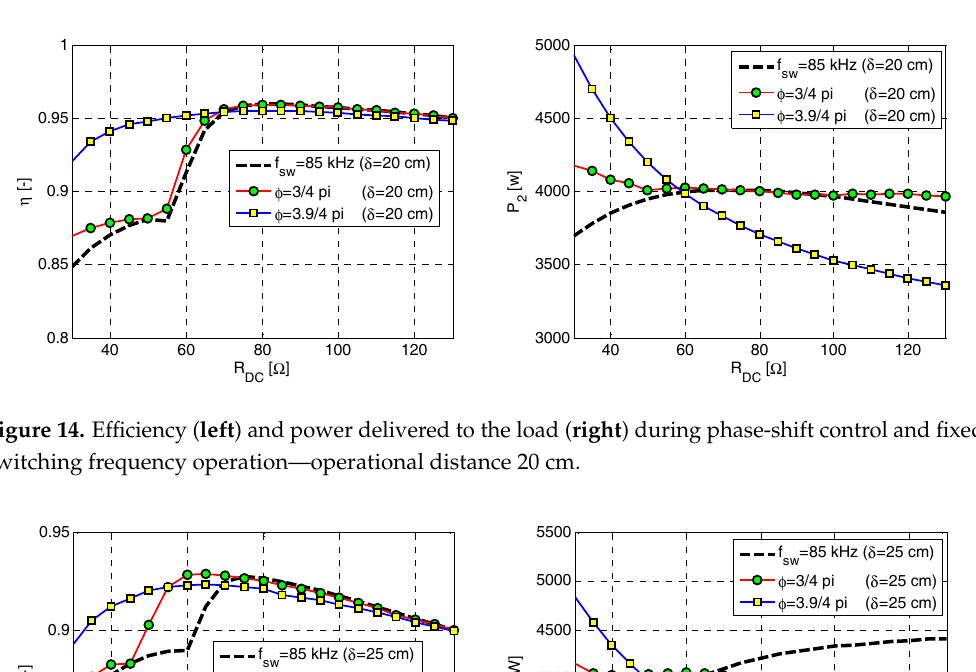
Figure 13. Efficiency ( left ) and power delivered to the load ( right ) during phase-shift control and fixed switching frequency operation—operational distance 15 cm.